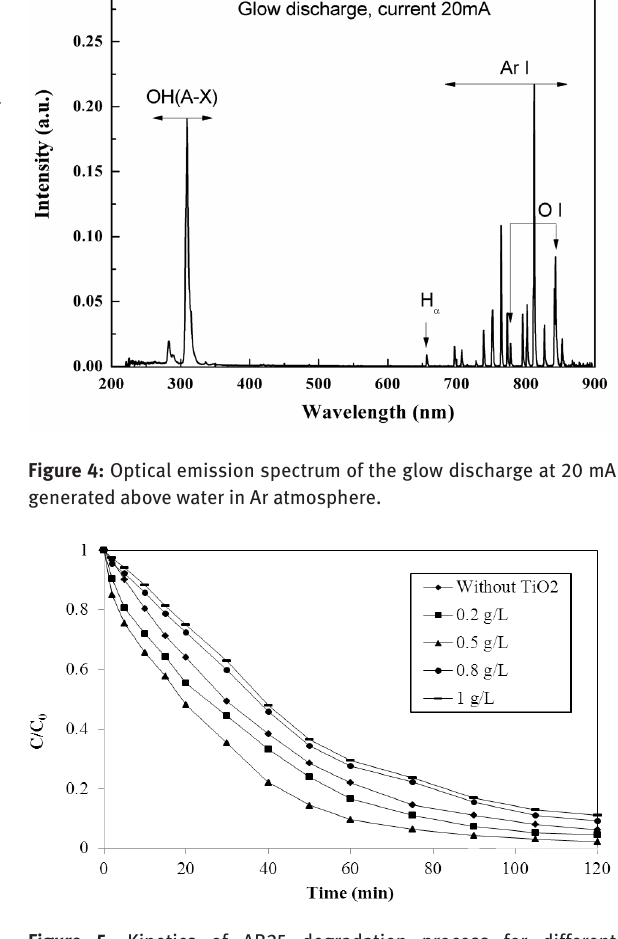
Figure 5: Kinetics of AB25 degradation process for different initial concentrations of TiO (treated volume 500 mL; initial dye 2 concentration 20 mg L -1 ; pH